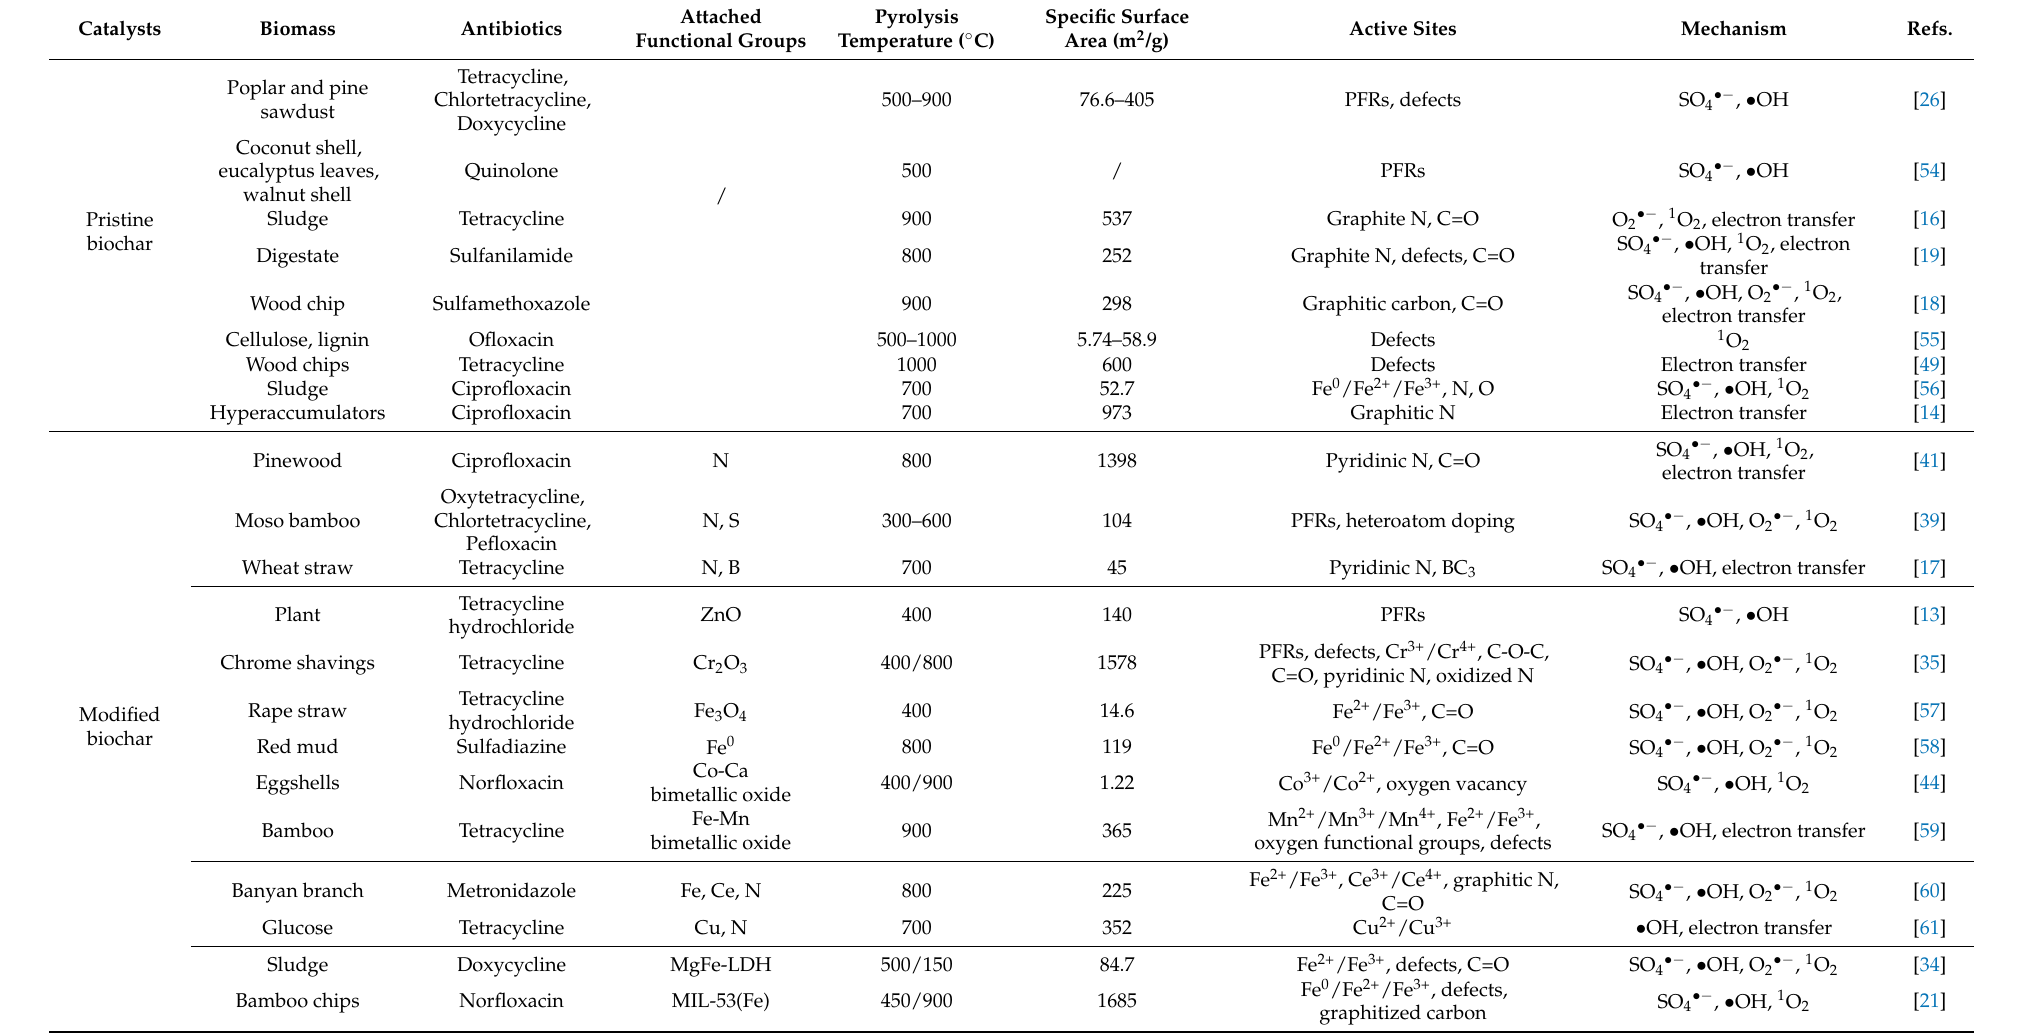
Table 3. Application of biochar catalysts in PS-AOPs for the removal of